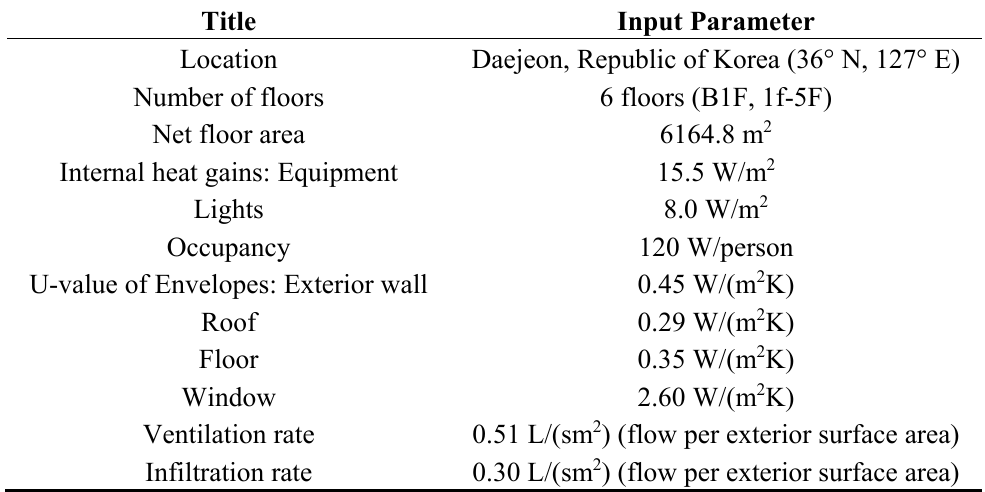
Figure A1. Hourly variations of internal loads following various schedules: ( a ) occupancy, and ( b ) indoor lights. The set temperatures for heating and cooling complied with the schedules: ( c ) heating and ( d ) cooling. Table A1. Office building specifications, internal heat gains, thermal performance of the envelopes, ventilation and infiltration rates for